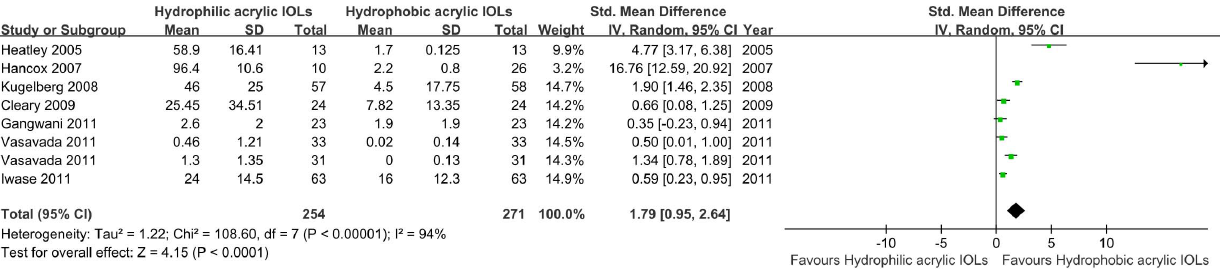
Figure 3. Forest plots describing effects of hydrophobic acrylic versus hydrophilic acrylic IOLs on development of posterior capsule opacification in 2-year follow-up. (Chi 2 = chi square statistic, CI = confidence interval, df = degrees of freedom, I 2 = I-square heterogeneity statistic, IV = inverse variance, SMD = standard mean difference, Z = Z-statistic).